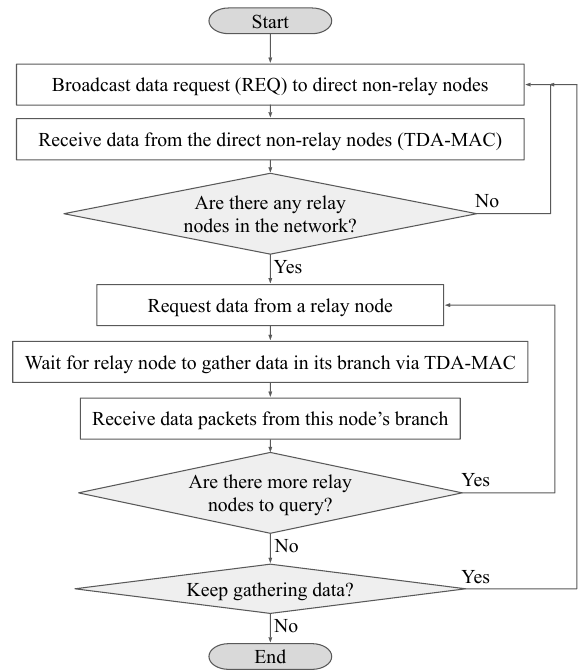
Figure 21. Sequential Dual-Hop TDA-MAC protocol [34]. The gateway node first gathers data packets from directly connected non-relay nodes using single-hop TDA-MAC, as depicted in Figure 20. It then instructs every relay node (sequentially) to gather data within its network branch (also using single-hop TDA-MAC) and relay it back to the